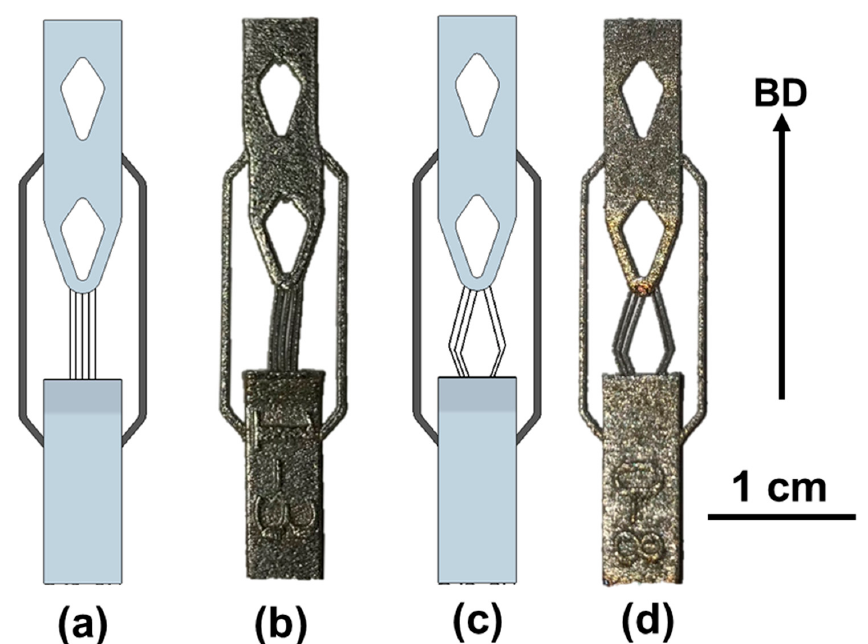
Figure 6. Printability assessment of the rectangular support indicating the deviation from the CAD model: ( a ) input model and ( b ) manufactured specimen geometry.